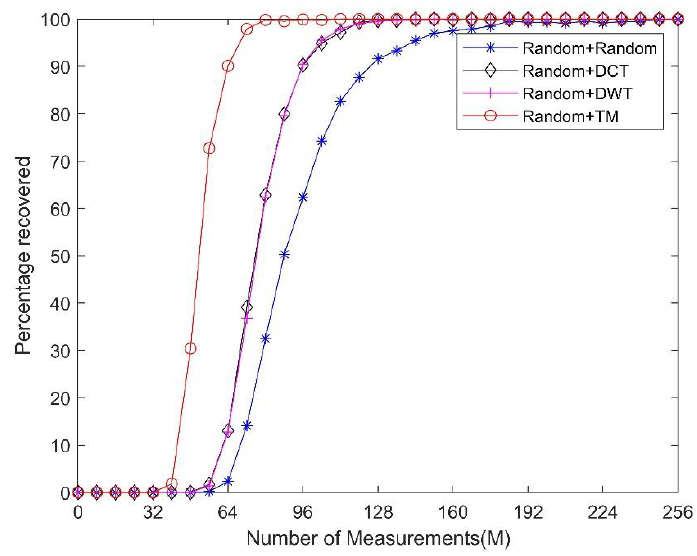
Figure 7. Comparison of the reconstruction performances using different sparsifying dictionaries under the same sparsity level K = 25 and the same random measurement matrix.